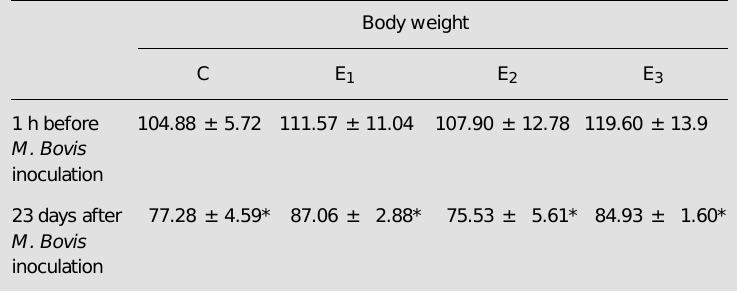
Table 2 - Area occupied by granulomas in the liver, lung and spleen of hamsters treated with 1.0